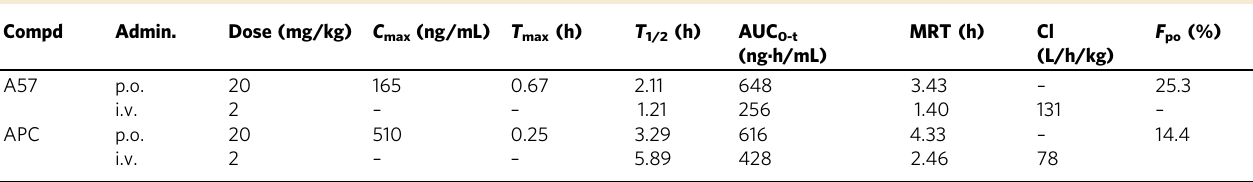
Table 1 Pharmacokinetic properties of compounds A57 and APC in ICR mice. Compd Admin.